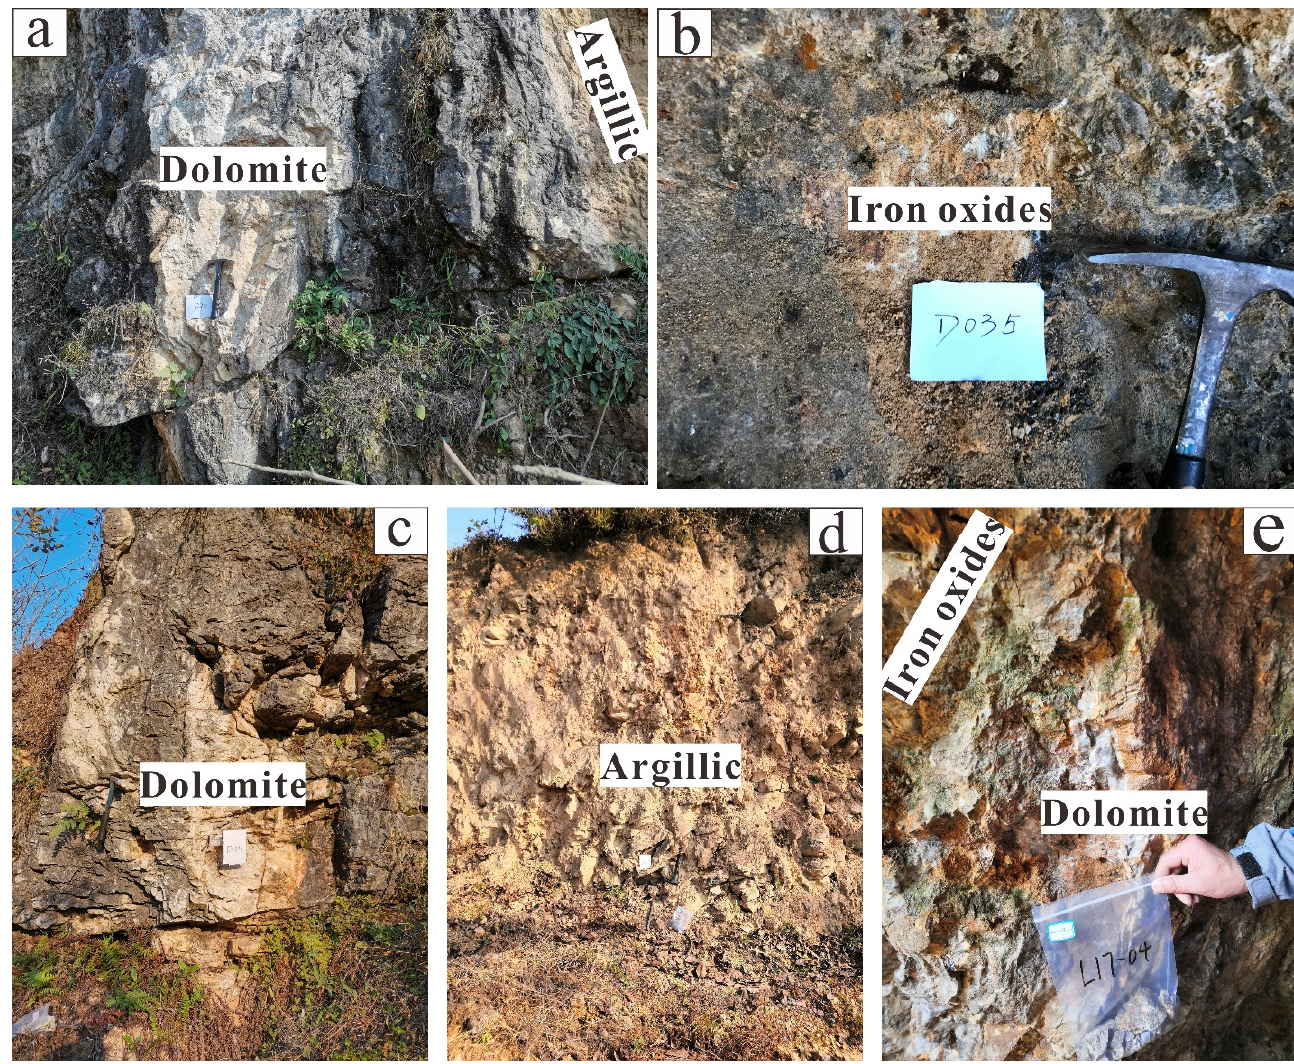
Figure 9. Typical field photographs of the hydrothermal alteration zones. ( a ) Dolomite and argillic alterations; ( b ) a close up of iron oxide alterations; ( c ) a view of the dolomite alterations; ( d ) a regional view of the argillic alterations; ( e ) iron oxide and dolomite alterations.